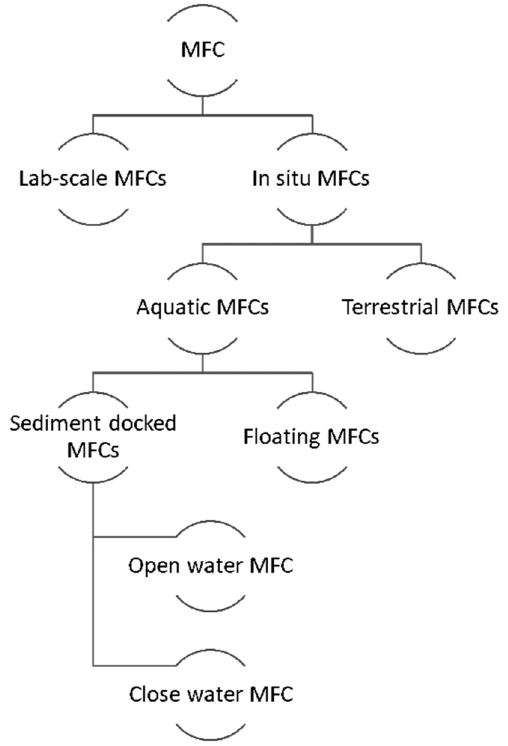
Figure 7. Classification of MFCs according to their placements.